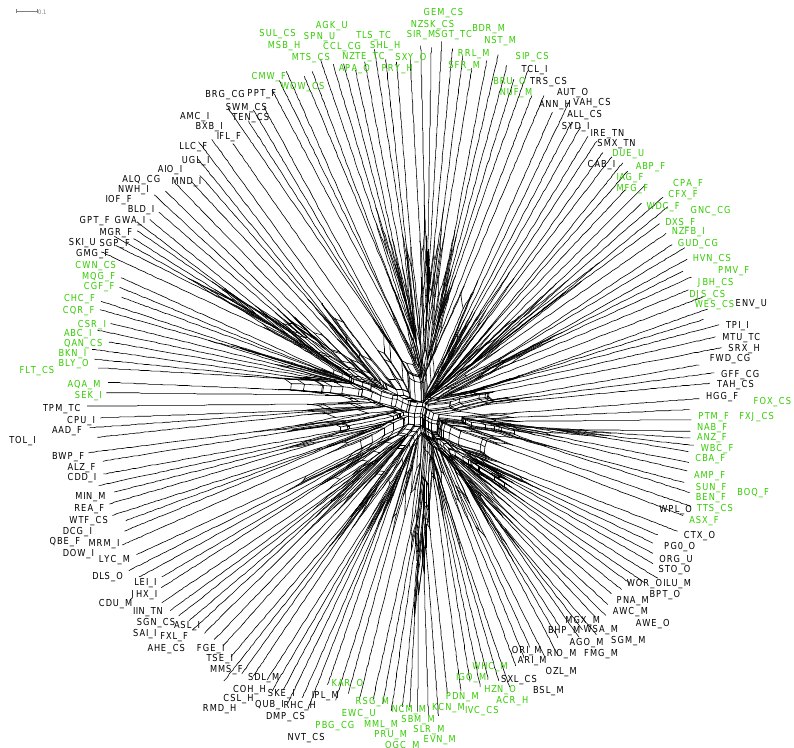
Figure 6. Period 5 neighbor-Nets splits graph with 10 clusters. A one or two letter code has been appended to each stock’s three letter ticker symbol to indicate what industry group it belongs to using the codes assigned in Table